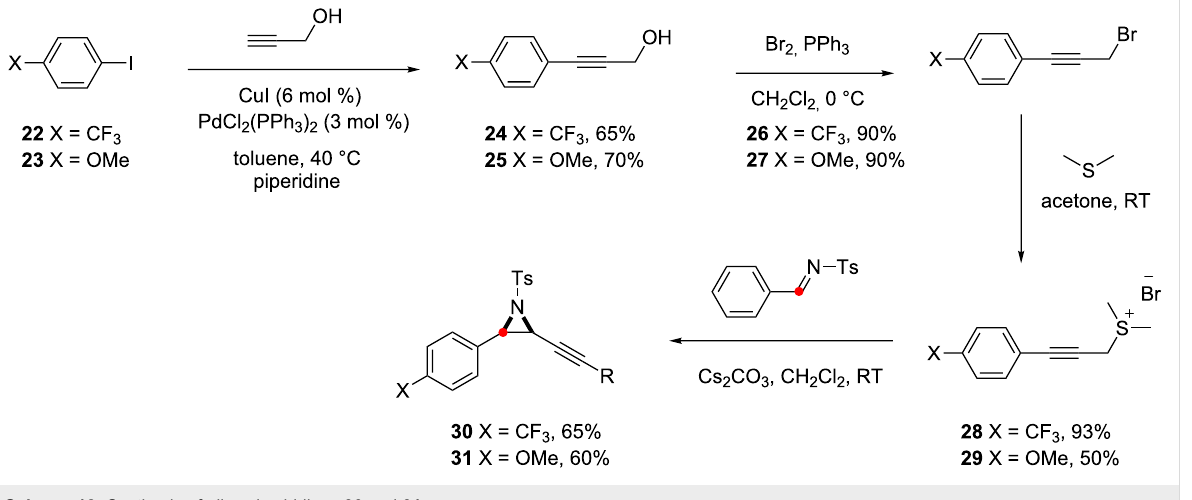
The initial report showed how the ratio of 2,5- to 2,4-disubsti- tuted pyrroles varied with the electronic properties of the aromatic unit substituent directly attached to the aziridine [18]. While the trend was consistent with that expected for a 1,2-aryl shift, the more complex mechanism also accounts for the observed outcomes. An increasingly electron-rich aryl group will favour both formation of benzylic cation I and 1,2-aryl migration from B , leading to the same products from each route. Electron-deficient aromatics would have a destabilising effect on the formation of I and also be less prone to undergo 1,2-aryl shift from B thus favouring Path I and formation of the 2,5- disubstituted